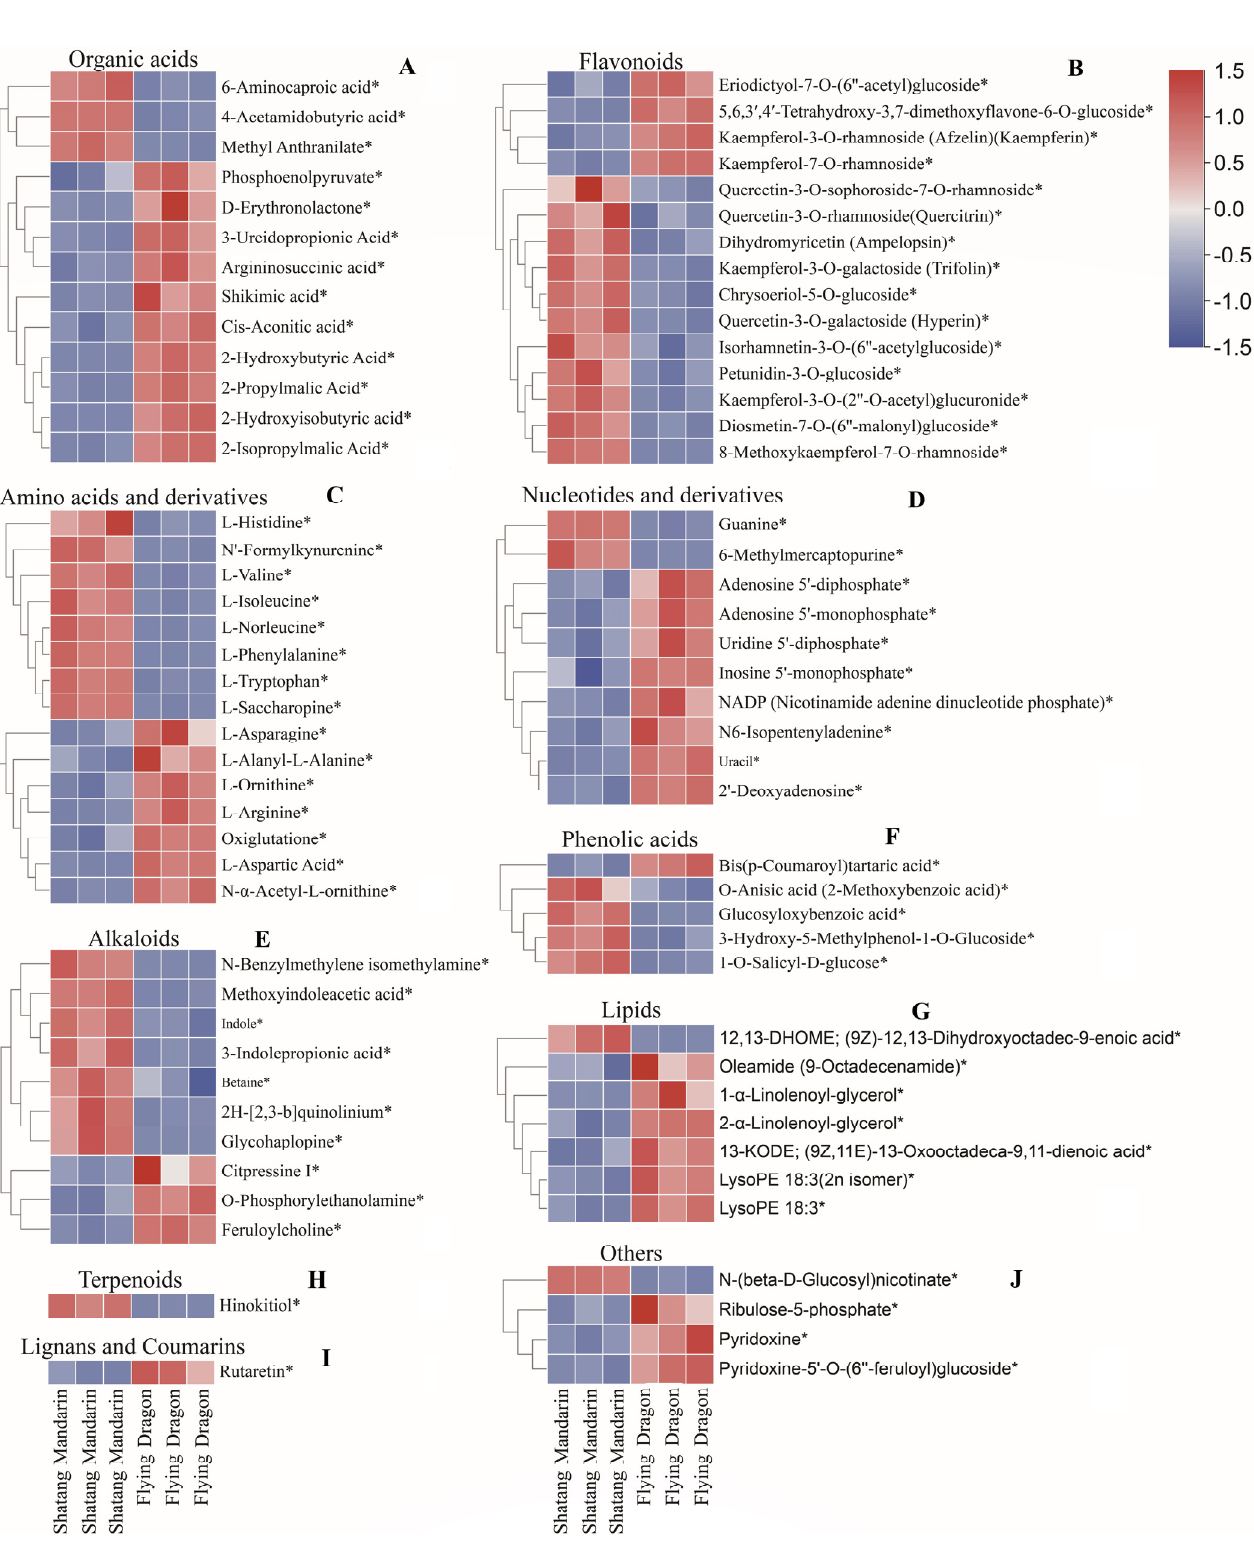
Figure 8. Heatmap of different metabolites in the leaves of ‘Shatangju’ mandarin scion cultivar grafted with ‘Flying Dragon’ (dwarfing) and ‘Shatang Mandarin’ vigorous rootstocks. Organic acids ( A ), Flavonoids ( B ), Amino acids and their derivatives ( C ), Nucleotides and their derivatives ( D ), Alkaloids ( E ), Phenolic acids ( F ), Lipids ( G ), Terpenoids ( H ), Lignans and Coumarins ( I ), and Others ( J ).